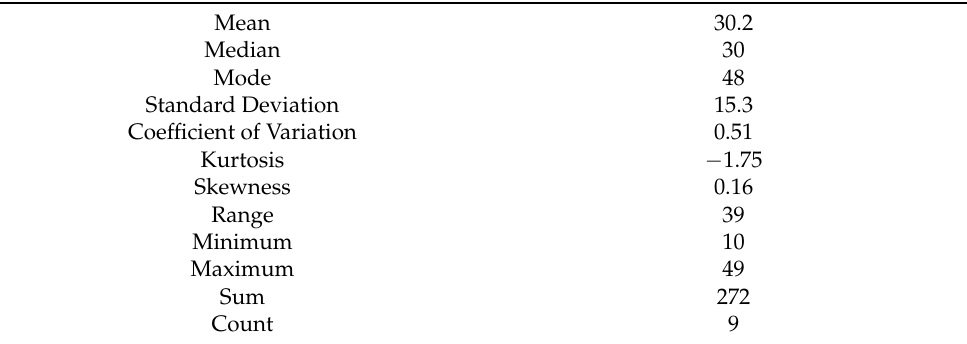
Table 2. Descriptive Stats of Citations of Energies